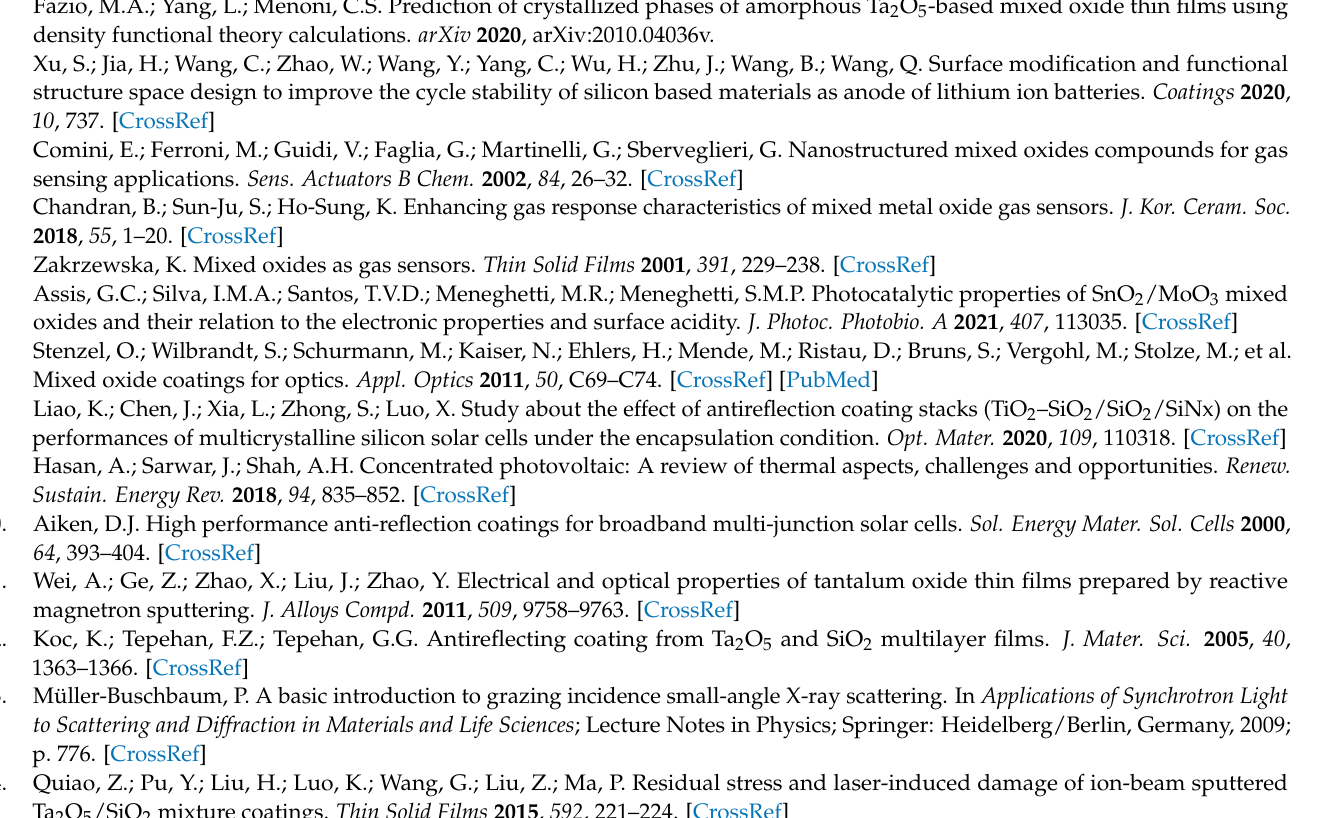
Table S3: Comparison of the actual composition of the oxide thin films, as determined by RBS and SE data